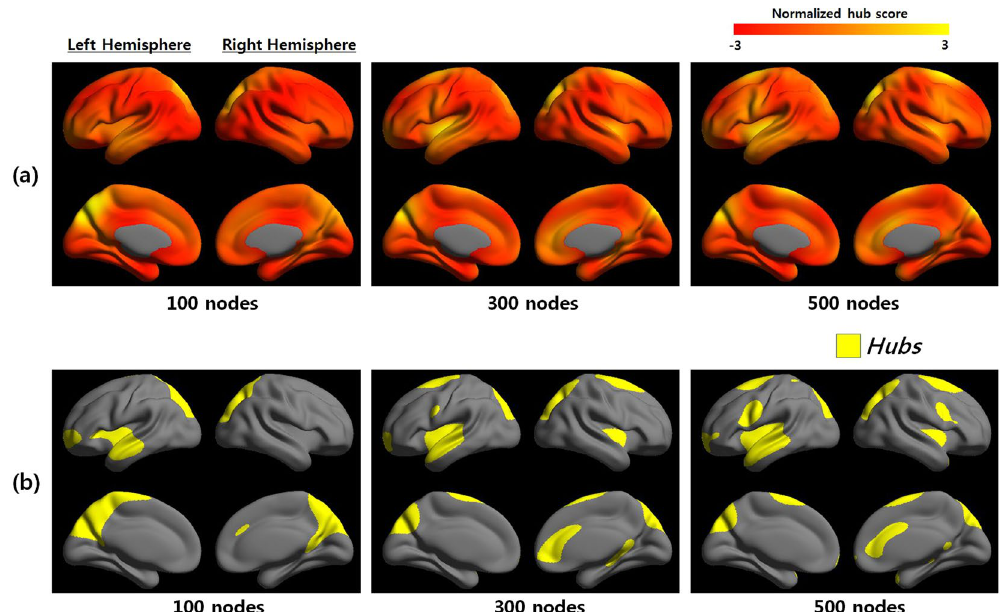
Figure 1. Betweenness centrality maps and hubs at multiple scales. ( a ) Betweenness centrality maps were shown at three network nodal scales (100, 300, and 500). The colored scale represented the hub score (red to yellow). ( b ) Hubs of three network nodal scales were defined by a standard deviation greater than the mean of the betweenness centrality hub map. Supplementary Table S3 showed the network hub at each scale in detail.